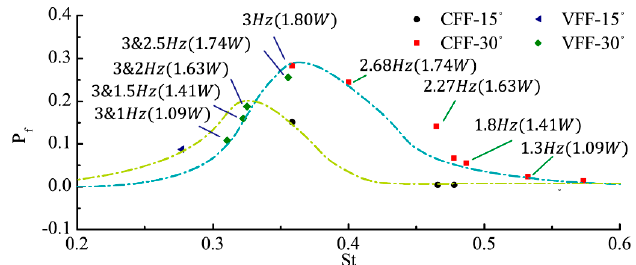
Figure 19. The lift efficiency and St number for the cases of installation angles 15°–30°.